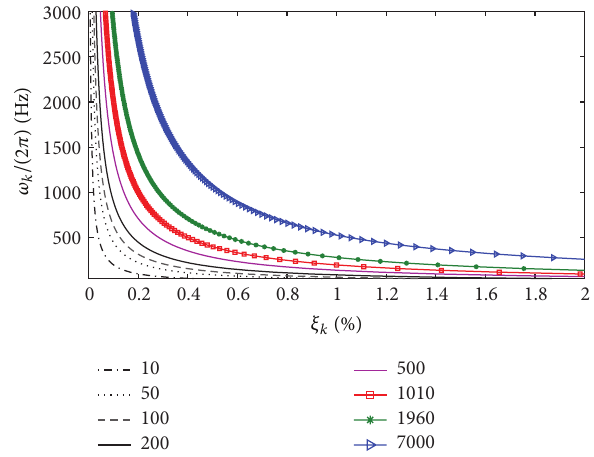
Figure 19: Relationship between the values of 𝜔 𝑘 and 𝜉 𝑘 which allowshavingavalueofPerf |𝑇 𝑧𝑤 | max equalto5 dBfordifferentvalues of 𝜓 2 𝑘 𝛾 (in rad 2 /s 2